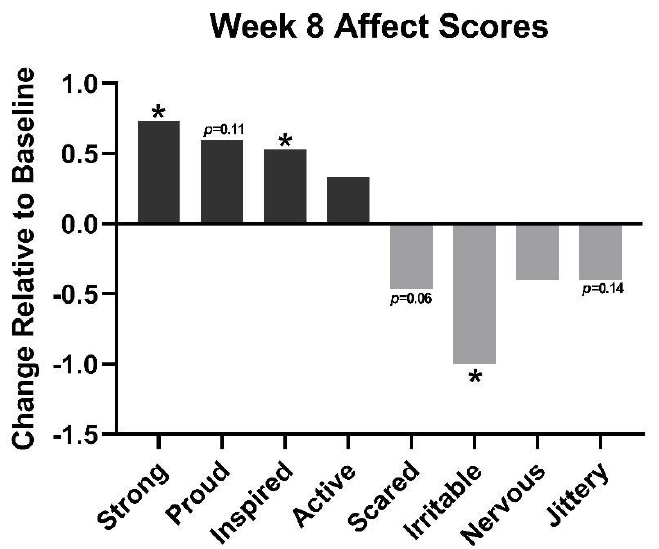
Figure 6. Components of positive effects (strong, proud, inspired, active) and negative effects (scared, irritable, nervous, jittery) at week 8 relative to baseline. * = p < 0.05.